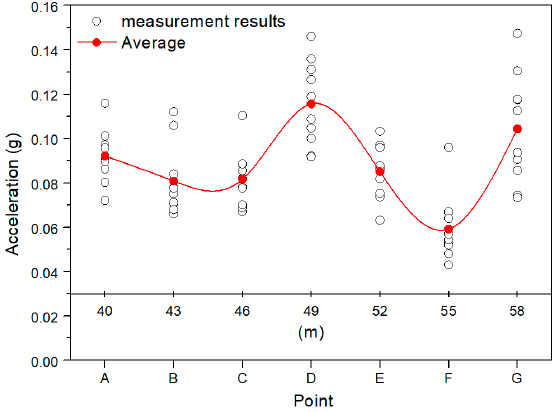
Figure 5. Results of acceleration measurement.